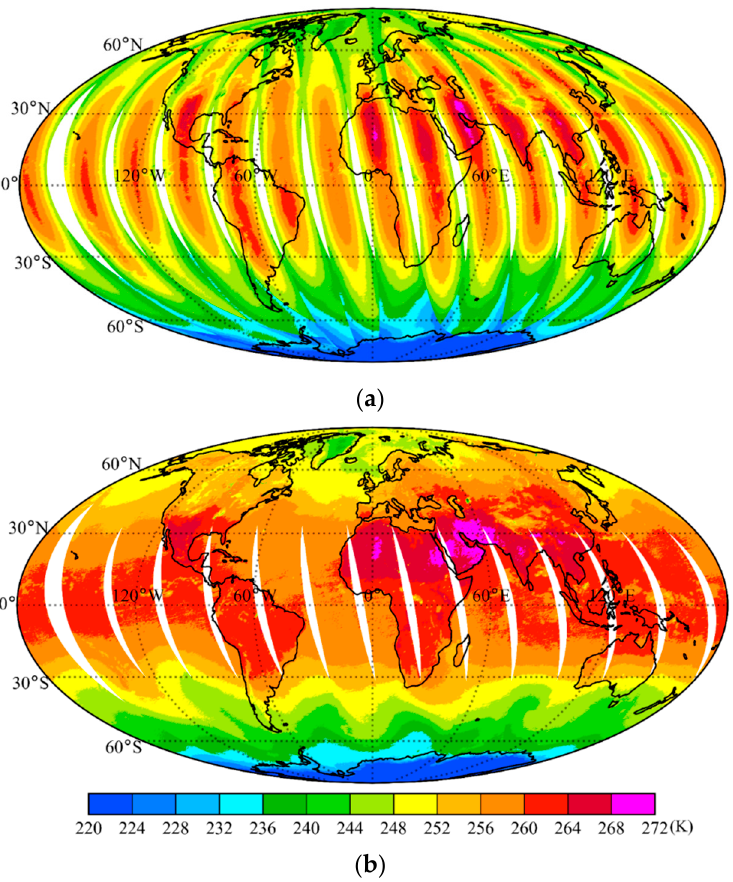
Figure 2. Global distributions of FY-3D MWTS-2 brightness temperature observations of channel 4 ( a ) before and ( b ) after the limb correction at the ascending node on 21 June 2019 (Unit: K). Supposing that the limb effect of a target channel can be compensated for by using linear combinations of its predictor channels at a given scan angle, the limb-corrected TB ( k ) ( i , j ) of MWTS-2 can be obtained as T b , LC